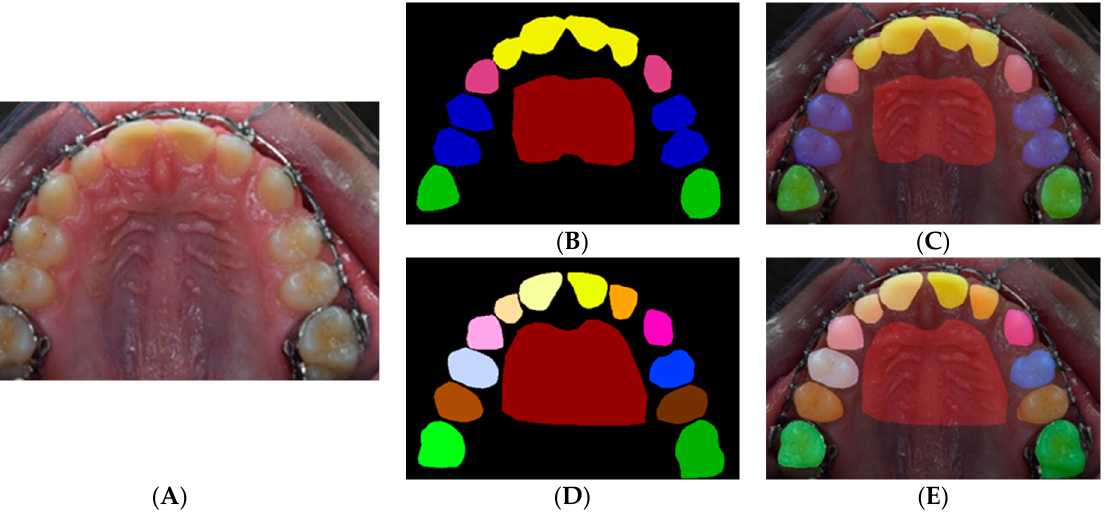
Figure 2. Labeling for semantic segmentation. The original image (all permanent teeth) ( A ); family segmentation: ( B , C ); family segmentation showing incisors (yellow), canines (pink), premolars (blue), molars (green), and rugae (maroon) ( B ); label superimposed on original image ( C ); individual teeth segmentation ( D , E ); a different color is assigned to every tooth ( D ); label superimposed on original image ( E ).